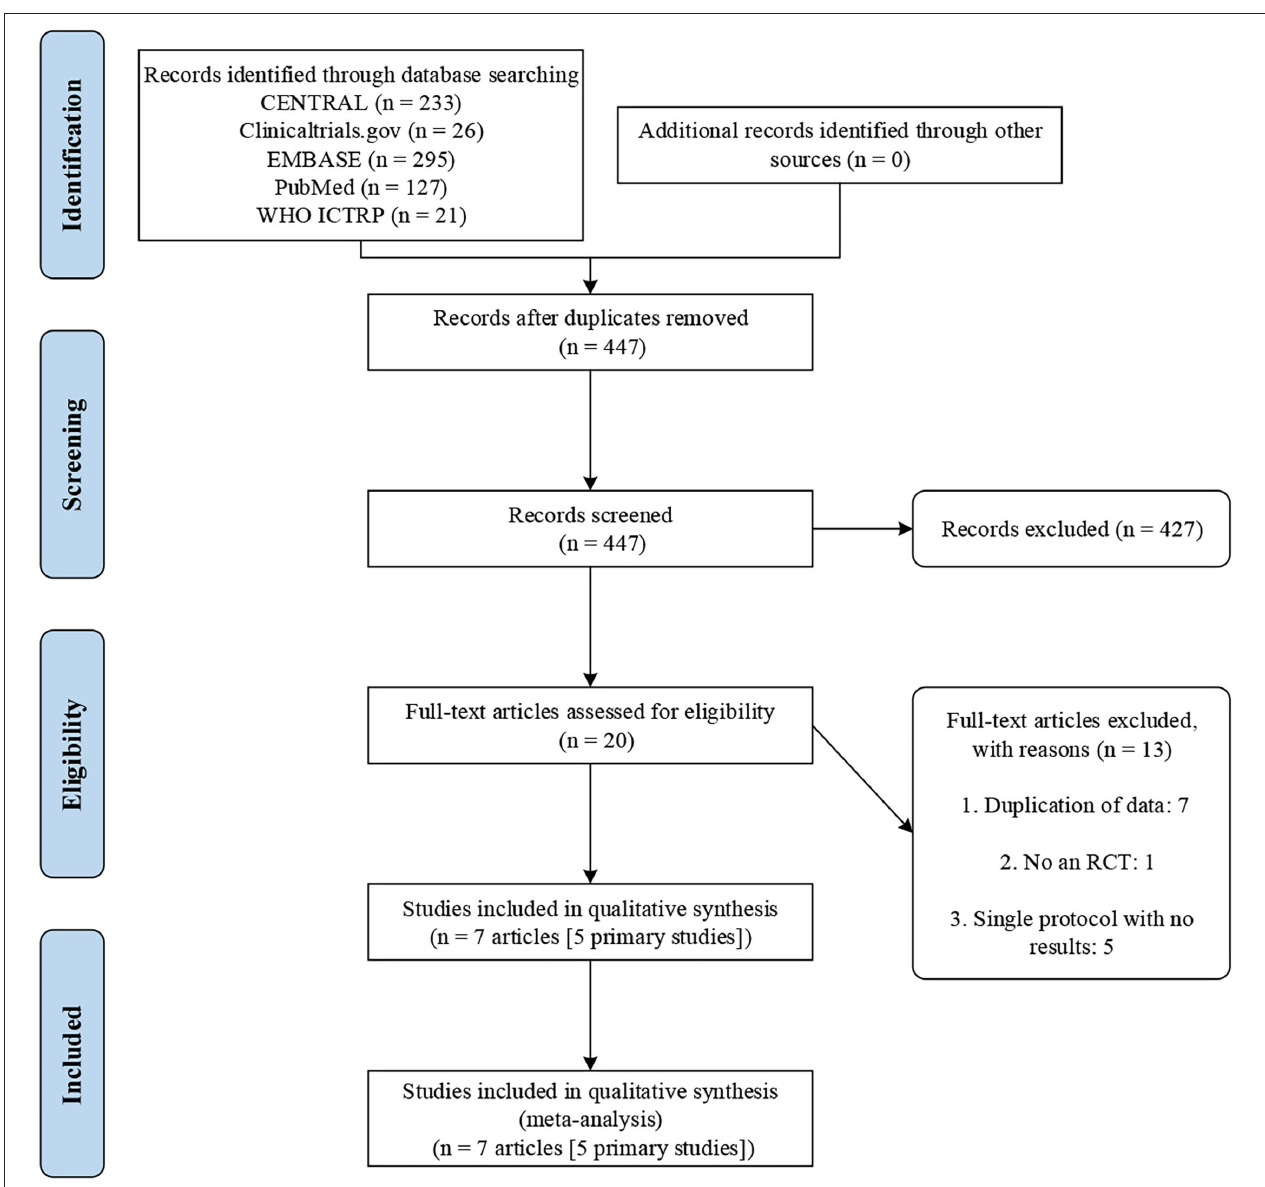
FIGURE 1 | PRISMA